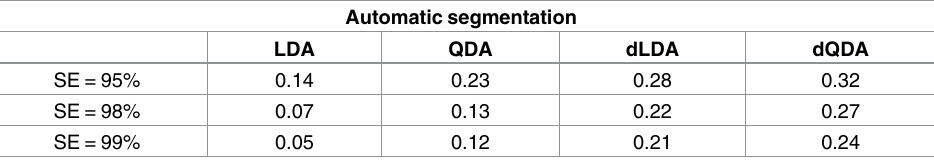
Table 3. High-sensitivity measuresfor Nevus Doctor using different